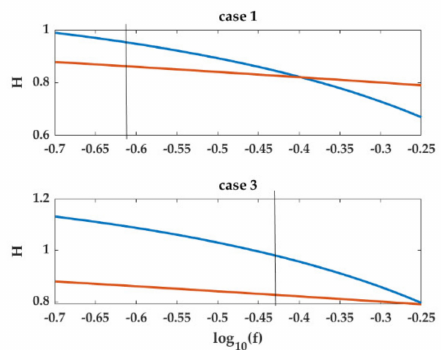
Figure 8. Sensitivity analysis of the estimated H from the residuals of the B-spline surface fitting by varying the cuto ff frequency. A plane is estimated with 1000 observations per line and the simulated noise is fGn with H ref = 0.9. Case 1 corresponds to the whole residuals, case 3 to the first line. Case with additional angle noise. The red curve corresponds to the GHE, the blue curve to the